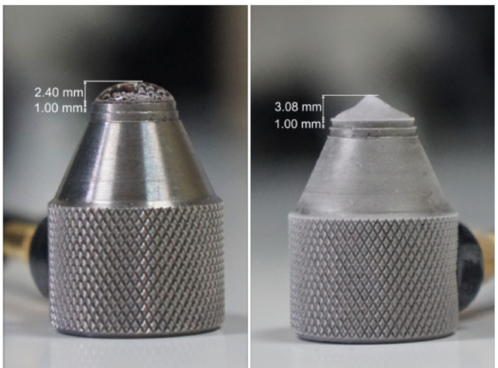
Figure 6. Optical determination of drop height at room temperature ( left panel), or as a frozen drop ( right panel). These pictures correspond to Ice Drop Experiment 1, discussed in the body of the